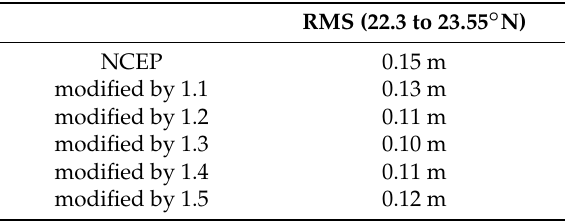
Table 2. RMS difference of non-tidal sea level anomalies between the model and T/P observations.